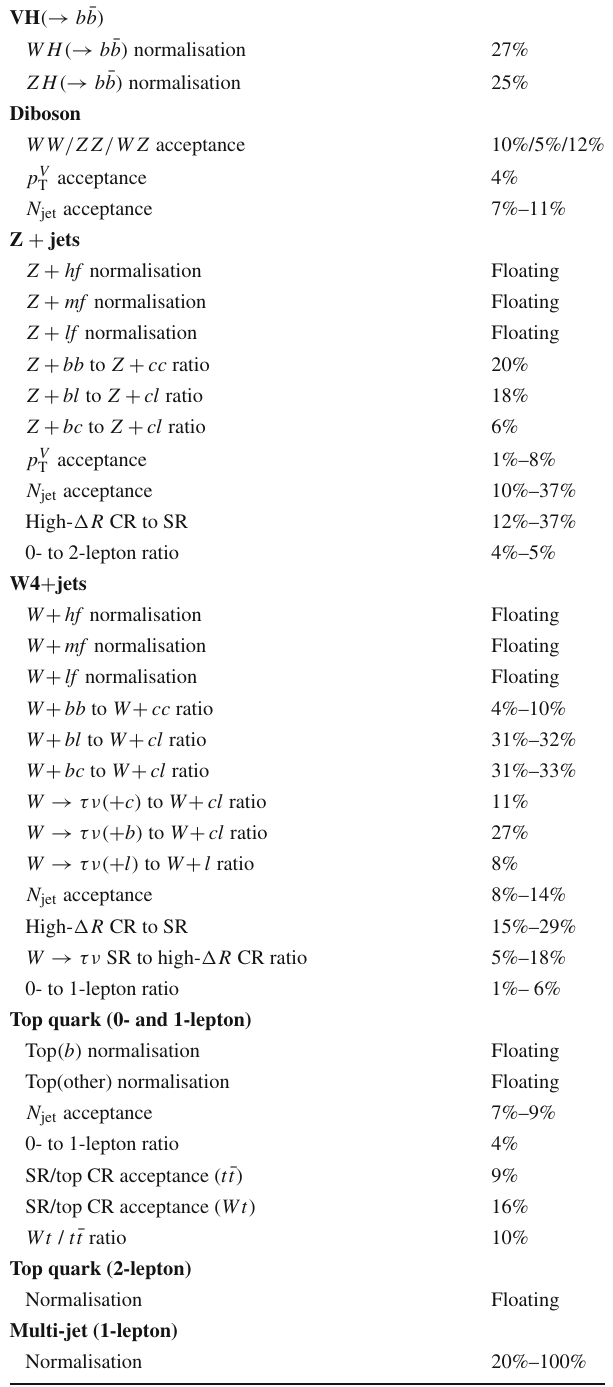
Table 3 Summary of the background modelling systematic uncertain- ties